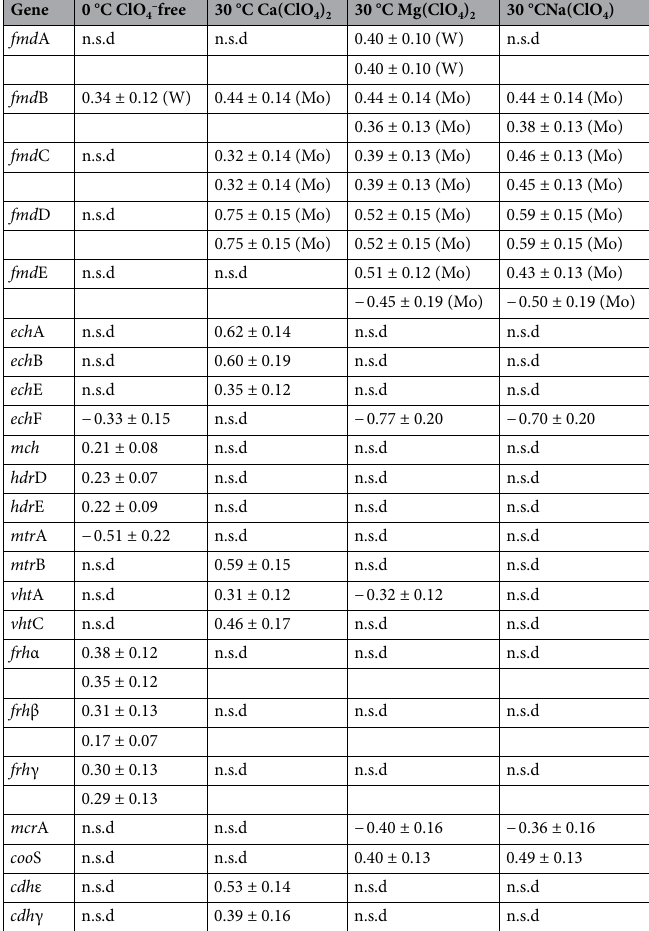
Table 1. Differential expression (Log 2 -fold change ± standard error) of M. barkeri MS genes implicated in the Wood-Ljungdahl pathway and hydrogenotrophic methanogenesis. LFC is relative to 30 °C perchlorate- free control. Multiple entries indicate statistical significance in multi-copy genes (Wald test, p < 0.05). Abbreviations: n.s.d., no significant difference from control; W, tungsten active site; Mo, molybdenum active site. If gene is not listed, no significant differential expression was observed across all treatments. Full names of genes are referenced in the text and are also listed in Table